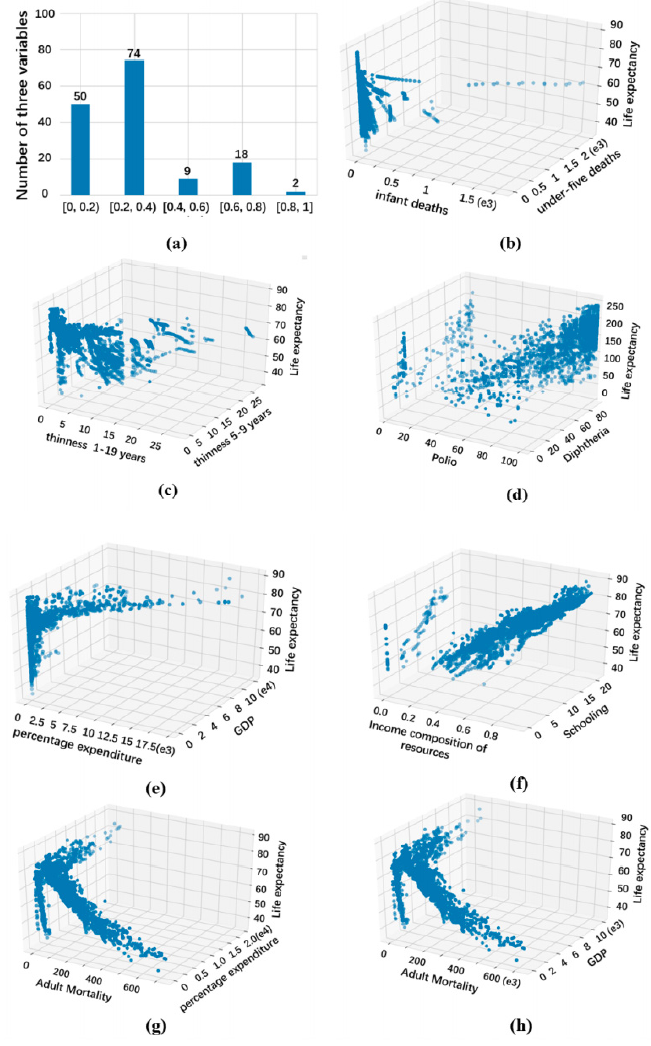
Figure 9. Exploring GHO dataset for trivariate associations with QOTIC.